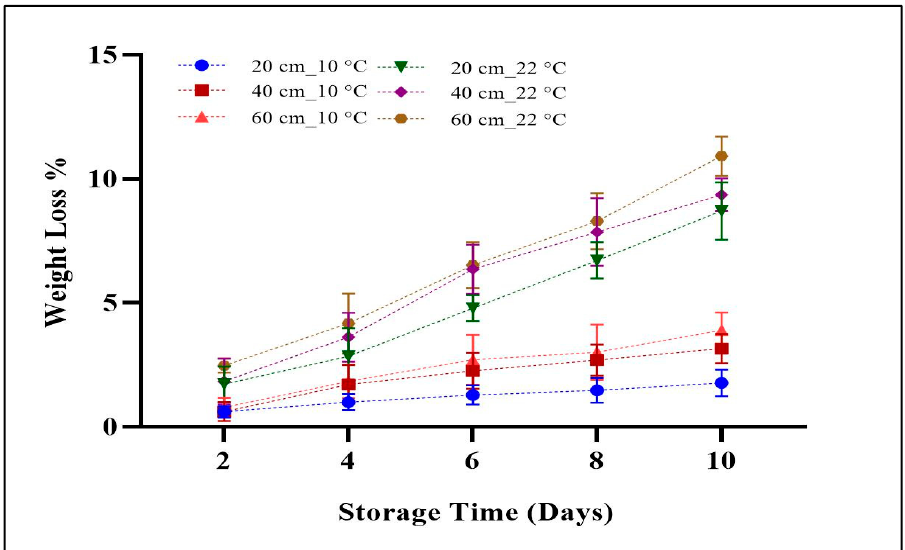
Figure 4. Weight loss (%) of tomato impacted at different drop heights (20 cm, 40 cm, and 60 cm) and stored for 10 days in 10 °C and 22 °C storage conditions. Error bars represent the standard deviation (SD) of the mean values ± S.D. of three replicates.